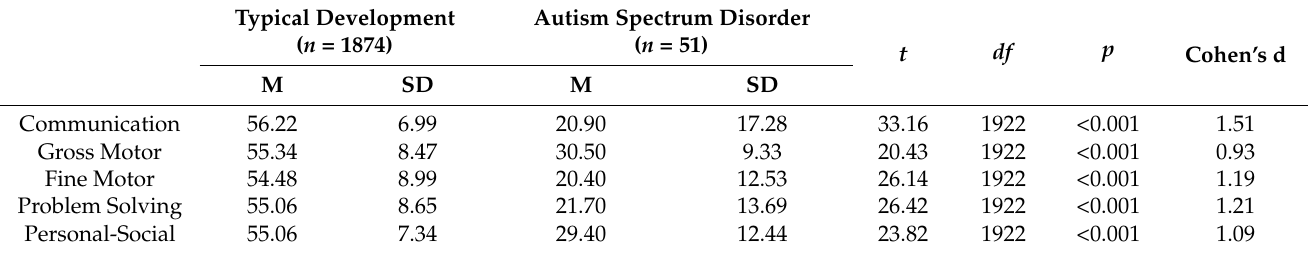
Table 7. Comparison group between children with Autism Spectrum Disorder and Typical Develop- ment on